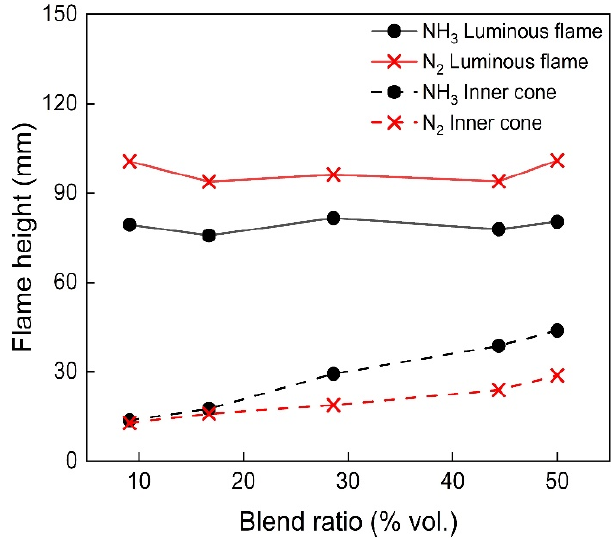
Figure 5. Comparison of the flame height of C 2 H 4 luminous flame height and inner cone as a func ‐ tion of different NH 3 and N 2 blend